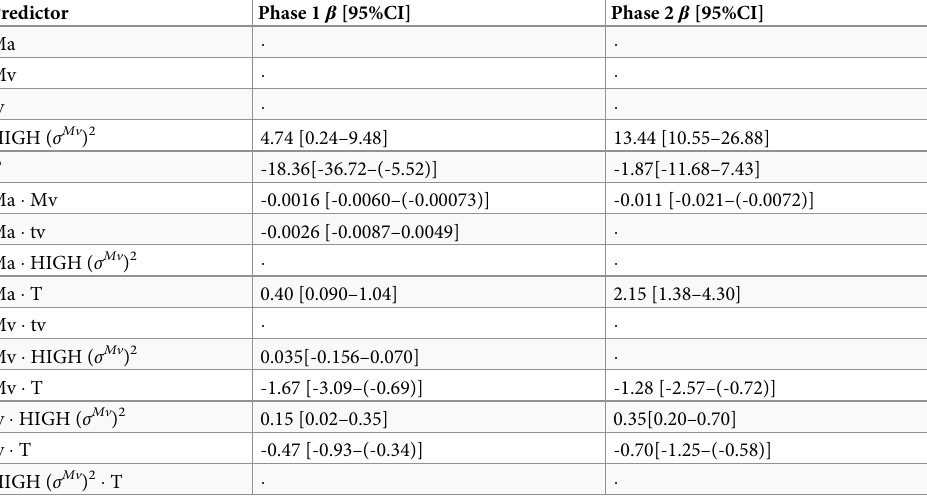
Table 2. Predictors for temporal hand error within a trial for Phase 1 and 2. λ = 0.6 for both models. As LASSO regression includes a penalization, caution is required when interpreting Confidence Intervals.